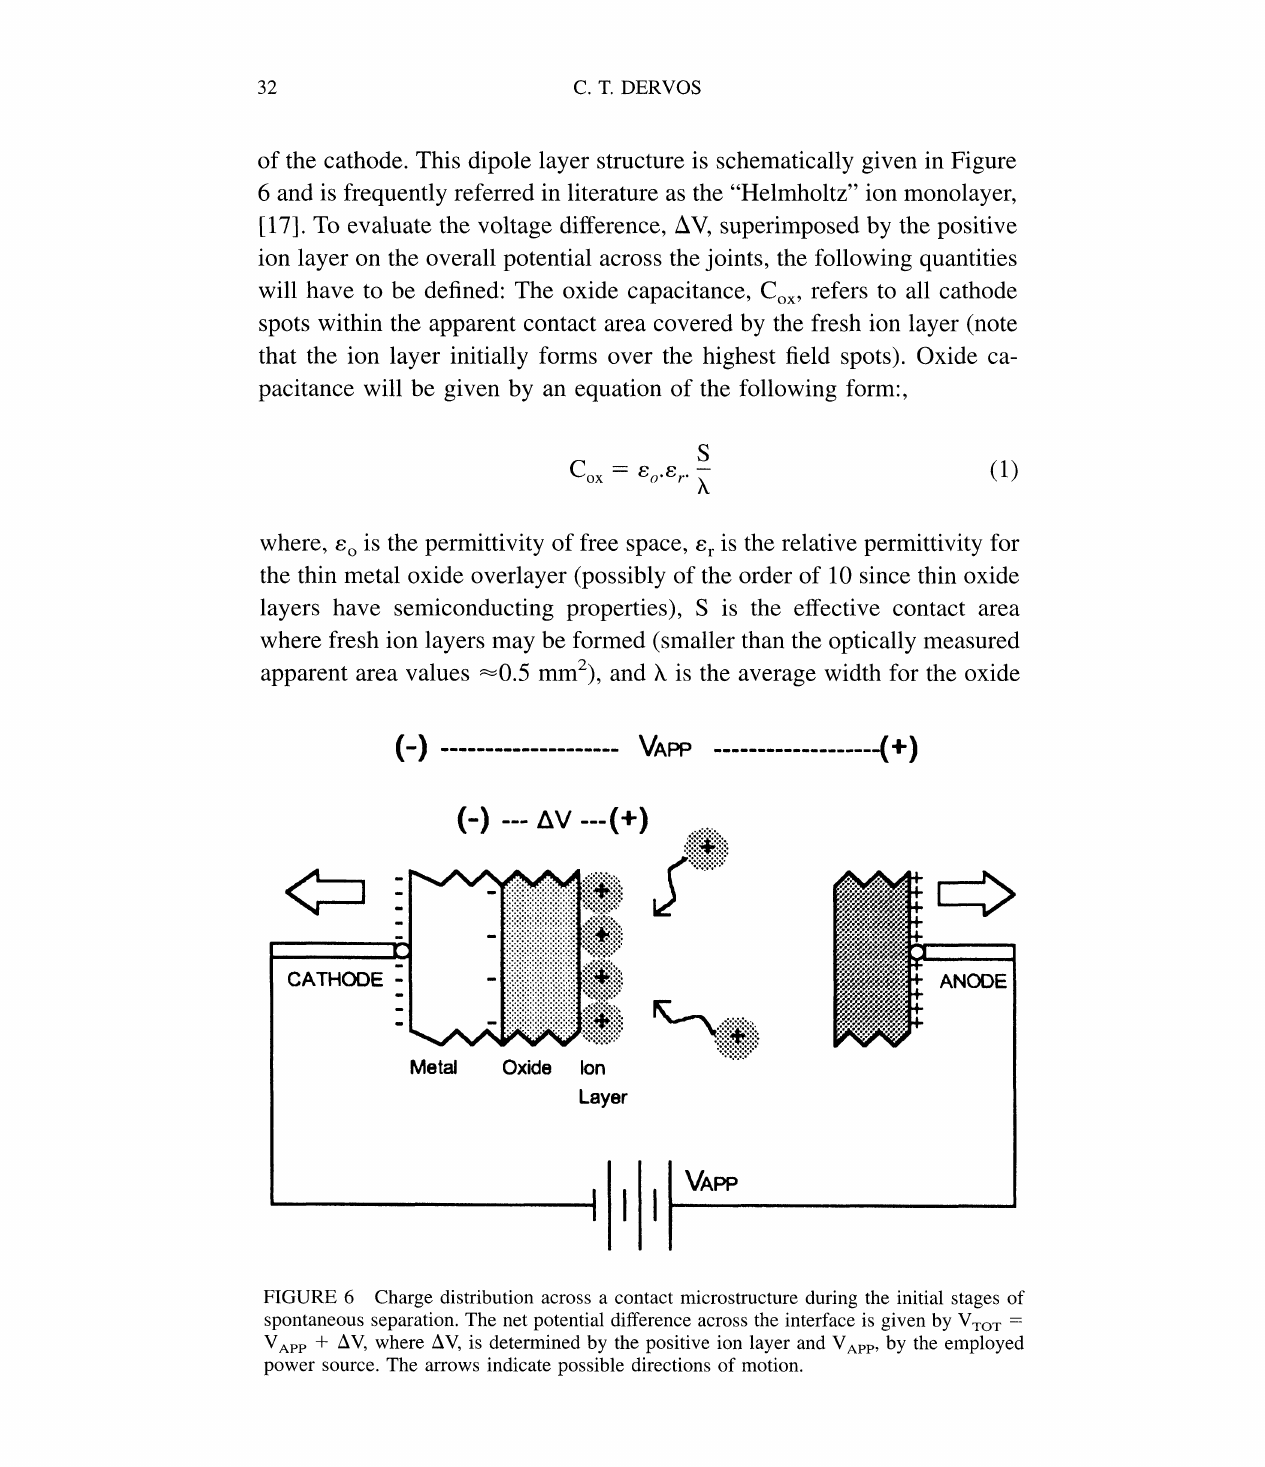
FIGURE 6 Charge distribution across a contact microstructure during the initial stages of spontaneous separation. The net potential difference across the interface is given by V:oT + AV, where AV, is determined by the positive ion layer and VAp,, by the employed VAp P power source. The arrows indicate possible directions of